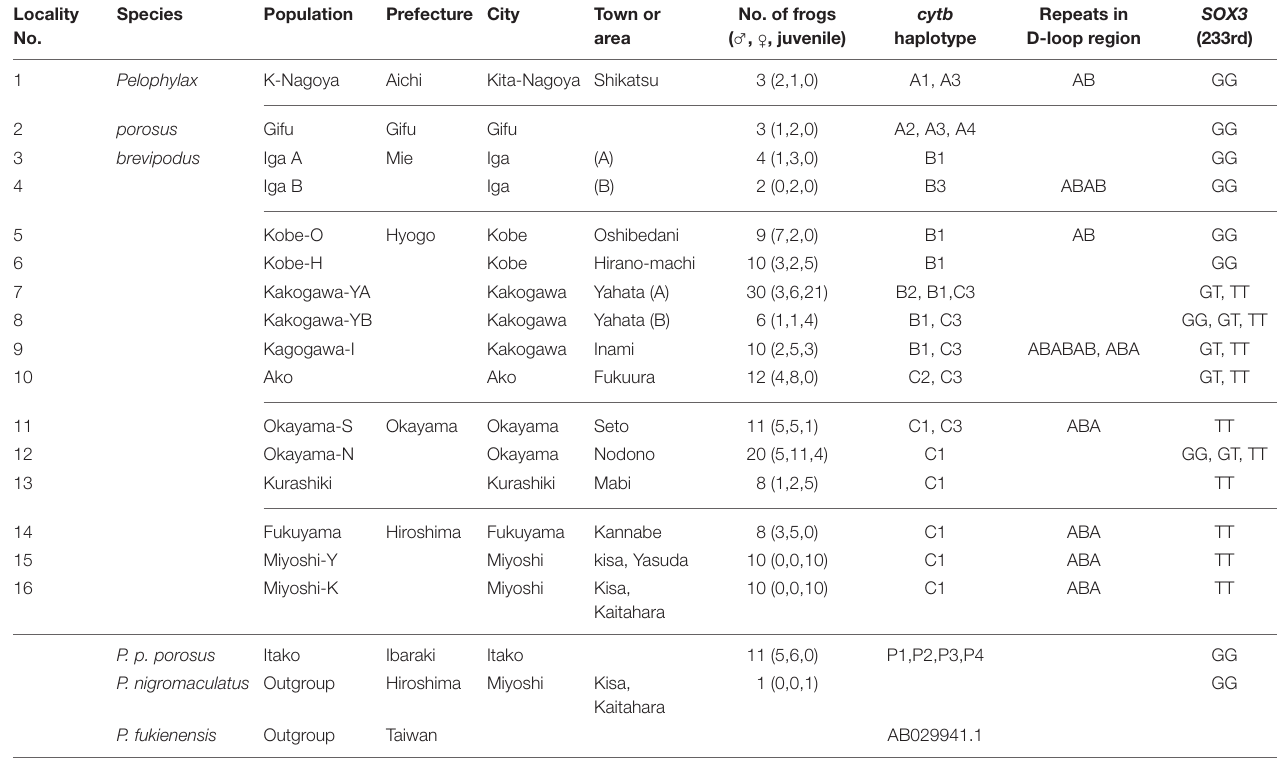
TABLE 1 | Populations, haplotype of mitochondrial cytochrome b, D-loop region, and genotype of nuclear SOX3 . Locality